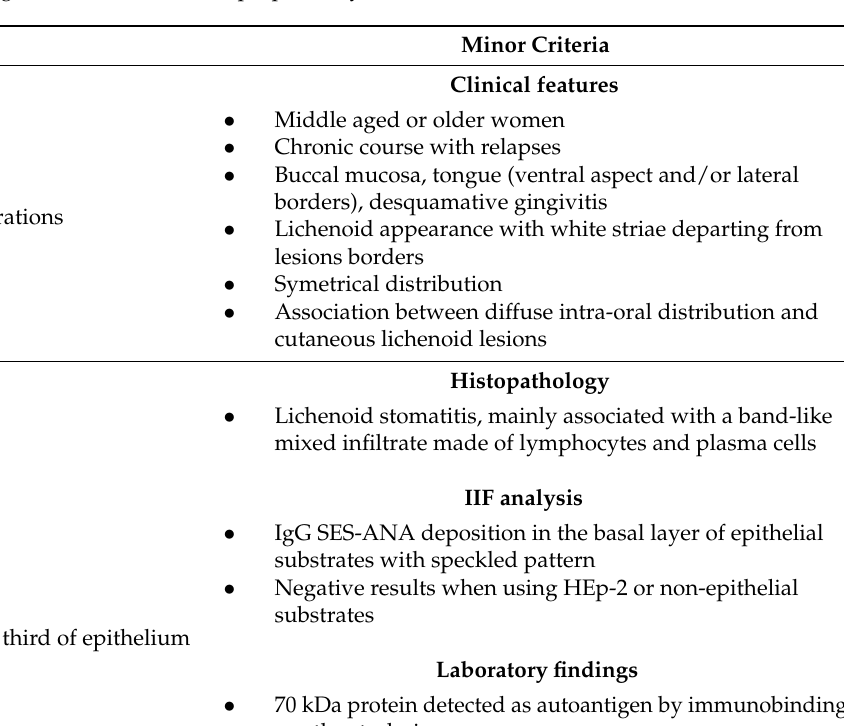
Table 1. Diagnostic criteria for CUS proposed by Azzi et al.